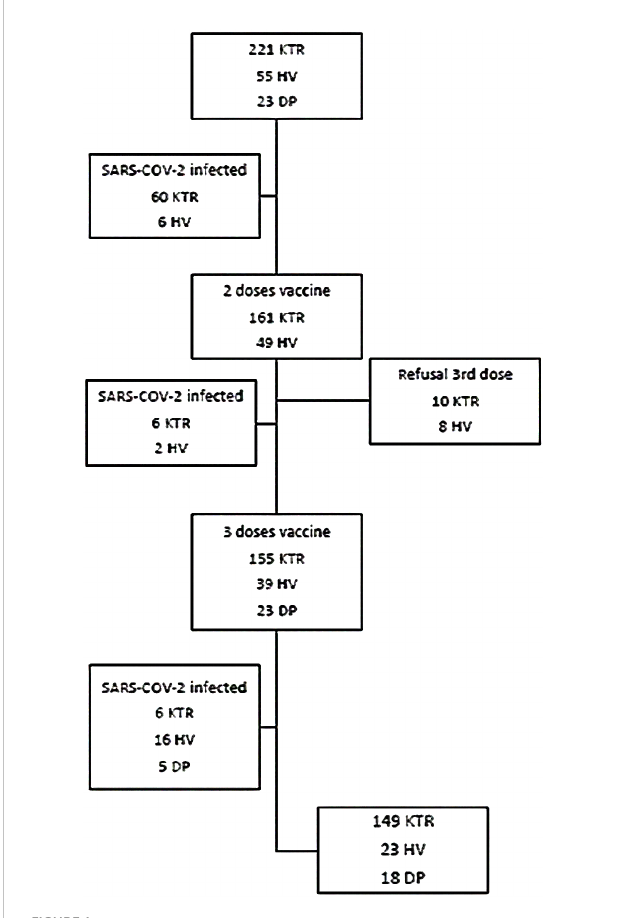
FIGURE 1 Study fl owchart. Patients and controls who were infected or refused to the third dose were excluded from the analysis of vaccine effectiveness. KTR, Kidney transplant recipients; HV, Healthy volunteers; DP, Dialysis